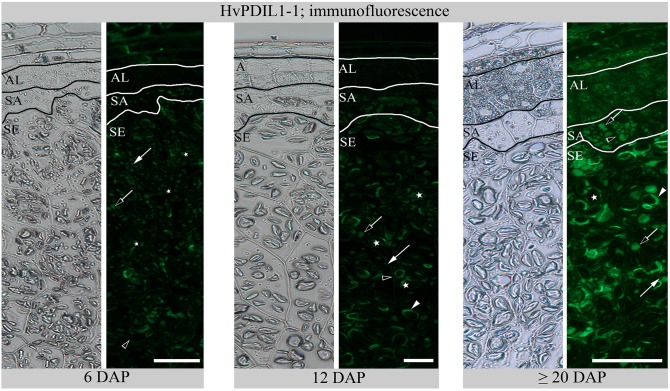
Immunofluorescence of HvPDIL1-1 with anti-AtPDIL1-1 at 6, 12, and ≥20 DAP. Aleurone (AL), subaleurone (SA), starchy endosperm (SE). Arrows indicate PBs with a smaller diameter, open arrows indicate PBs with a larger diameter and arrowheads the specific signal from the protein matrix at the periphery of the starch granules (asterisks). See the labeling of the plasma membrane in starchy endosperm (SE) at 12 DAP and in aleurone (AL) and subaleurone (SA) at ≥20 DAP (open arrowheads). Note the weak signal in aleurone (AL) at ≥20 DAP. Scale bar = 50 μm.